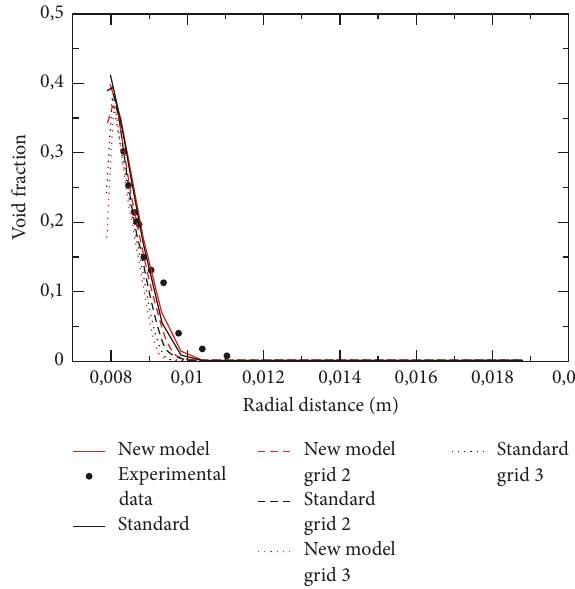
Figure 56: ASU void fraction with the new and standard models.